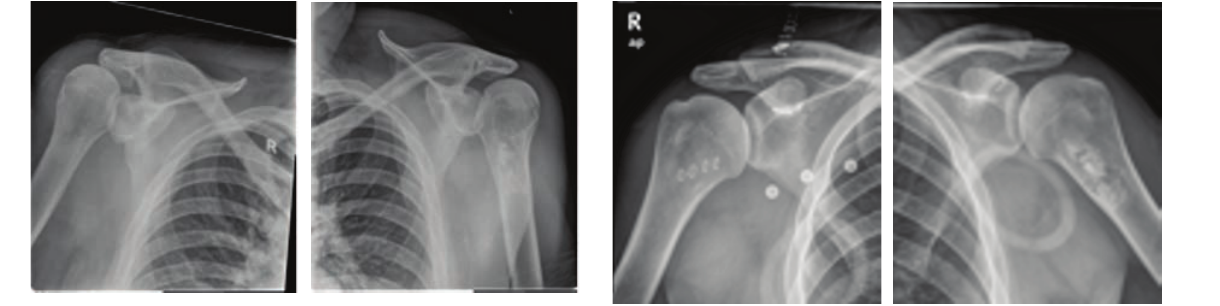
Figure 3. axial CT scan of right and left shoulder showing reverse Hill-Sachs lesions with impression defect of the humeral head - arrows )